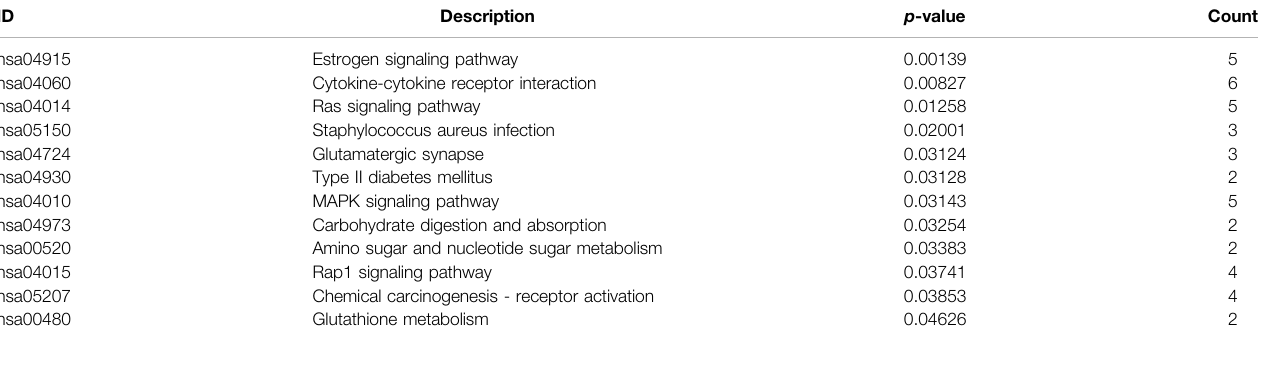
TABLE 4 | Results of KEGG enrichment analysis of differential